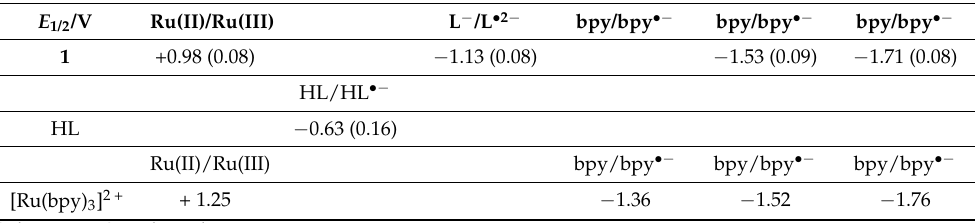
Figure 2. Cyclic voltammograms of HL (green) and complex 1 (red) in acetonitrile. Open circuit potentials and the initial scan directions are indicated by the black cross and arrow. Table 2. Redox potentials for complex 1 , HL, and [Ru(bpy) 3 ] 2+ (versus SCE). The difference be- tween E p,c (peak potential of cathodic current) and E p,a (peak potential of anodic current) is shown in